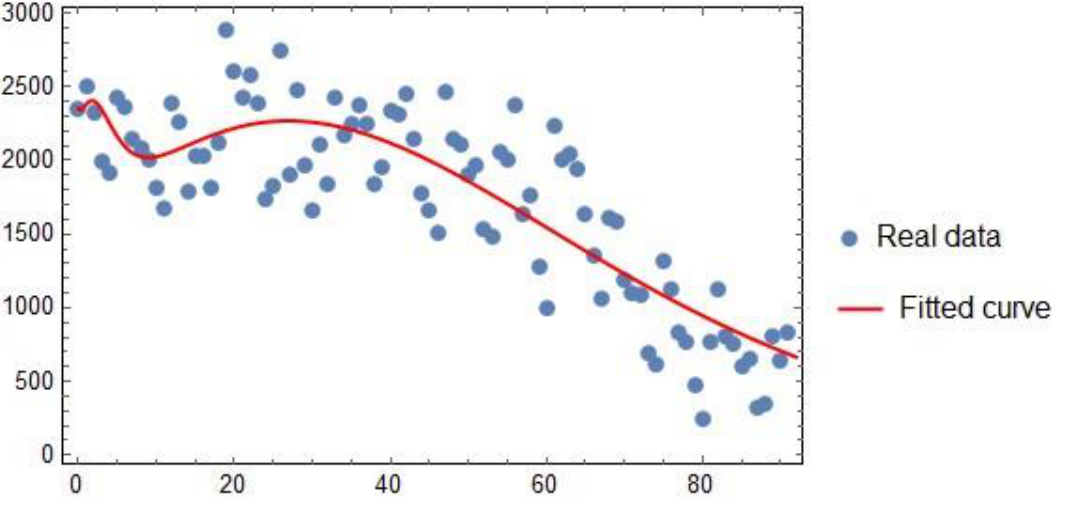
Figure 7. Model fitting using the real data.